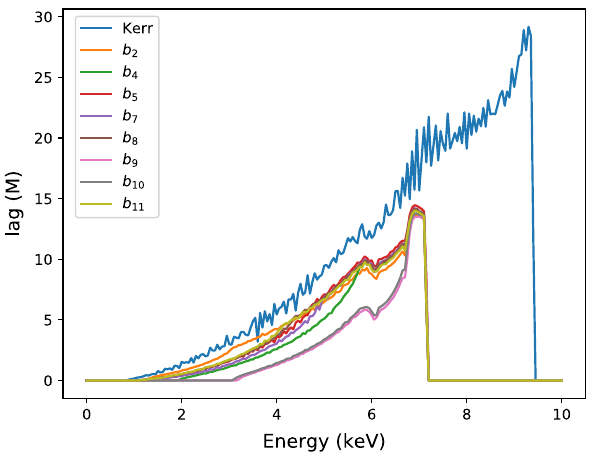
Fig. 8 Lag vs energy for different b i = 5. The spin parameter is 0 . 95 and the viewing angle is 45 ◦ . The height of the corona is 10. The fre- quency range is ( 3 − 4 ) × 10 − 3